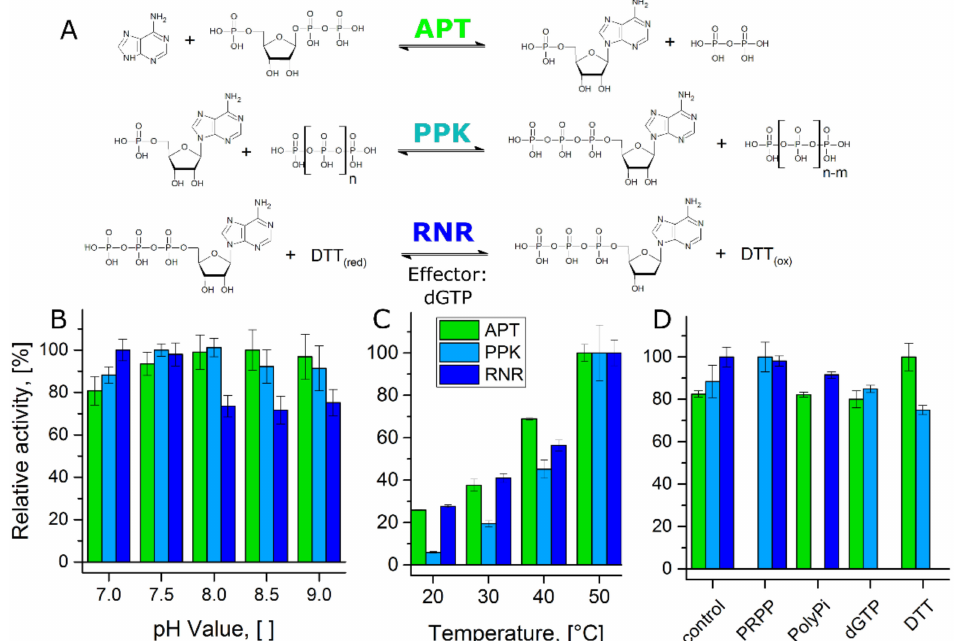
Figure 2. Compatibility test of the single reactions in the cascade: ( A ) Single reaction steps of the cascade with substrates, co-substrates, products, and effector. ( B ) Relative activity of the enzymes at 40 ◦ C in a pH-range from 7.0 to 9.0. 100% relative activity corresponds to 324 U mg − 1 (APT), 27 U mg − 1 (PPK), and 0.52 U mg − 1 (RNR), respectively. PPK activity was determined for the conversion of AMP to ADP. ( C ) Relative activity of the enzymes at a pH-value of 8.0 in a temperature range from 20 ◦ C to 50 ◦ C. 100% relative activity corresponds to 586 U mg − 1 (APT), 55 U mg − 1 (PPK), and 0.78 U mg − 1 (RNR), respectively. PPK activity was determined for the conversion of AMP to ADP. ( D ) Relative activity of the enzymes at 40 ◦ C and a pH-value of 8.0 in the presence of substrates and effector from the other reaction steps. 100% relative activity corresponds to 391 U mg − 1 (APT), 31 U mg − 1 (PPK), and 0.44 U mg − 1 (RNR), respectively. PPK activity was determined for the conversion of AMP to